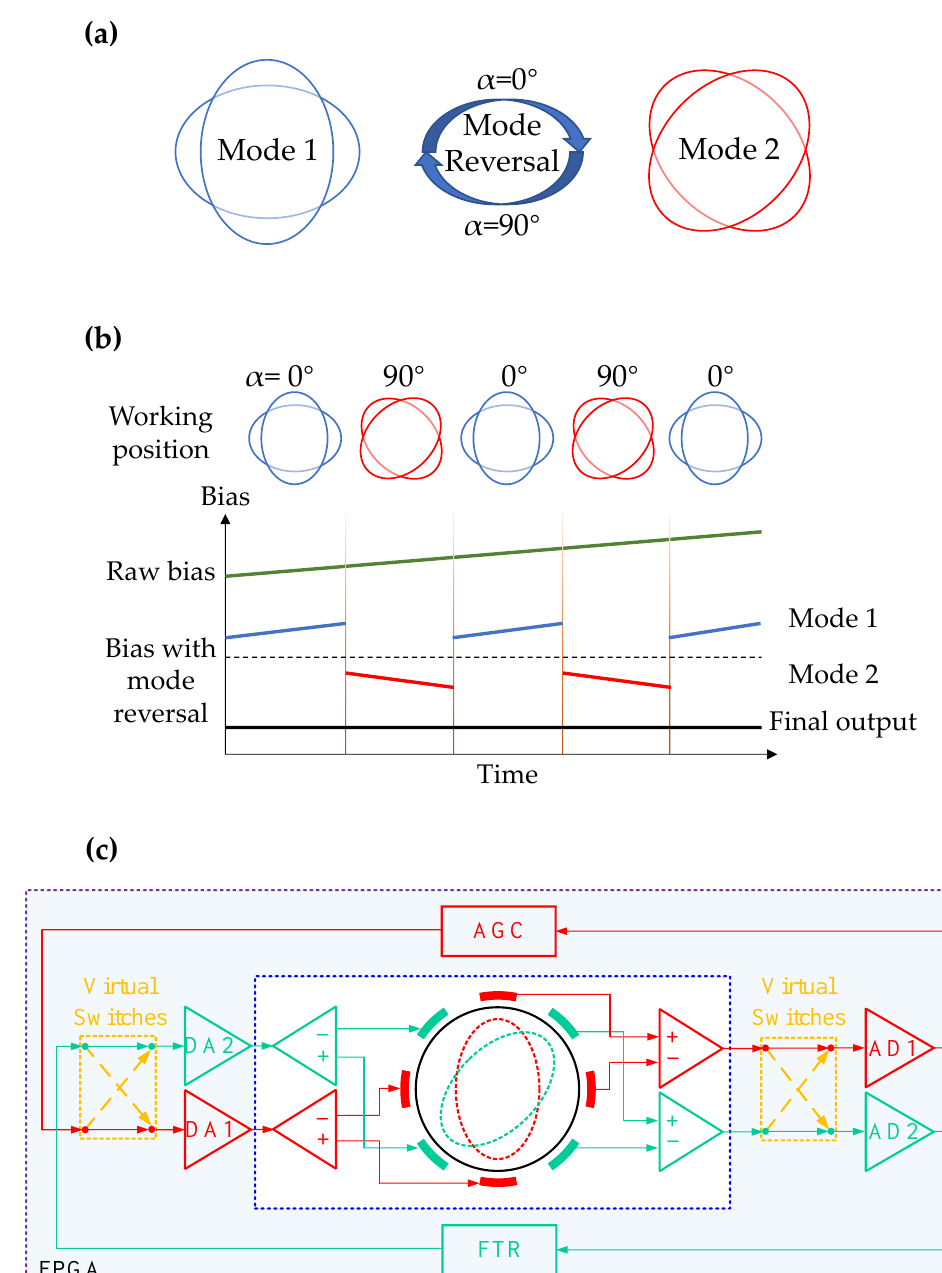
Figure 3. ( a ) Mode reversal schematic. ( b ) Mode reversal working sequence diagram. ( c ) Electronic and control scheme of mode reversal in the HDRG. and control scheme of mode reversal in the